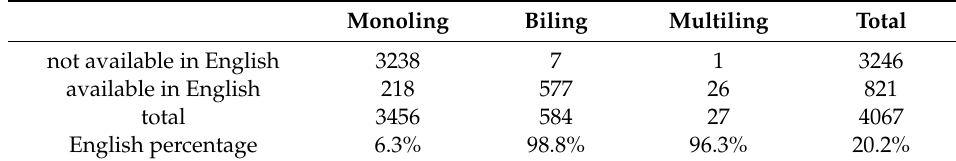
Table A14. English language availability (dk).